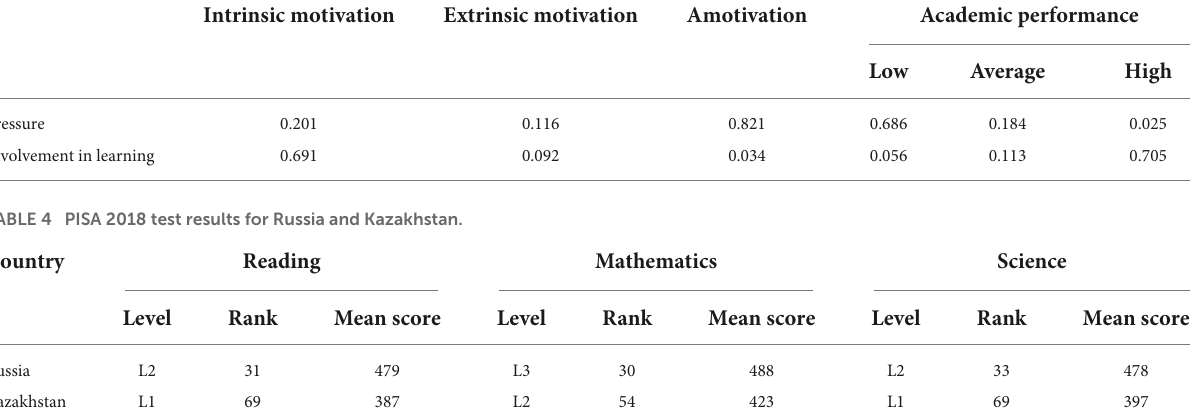
TABLE 3 Correlation between the motivation types, academic performance and pressure/support from teachers and parents.